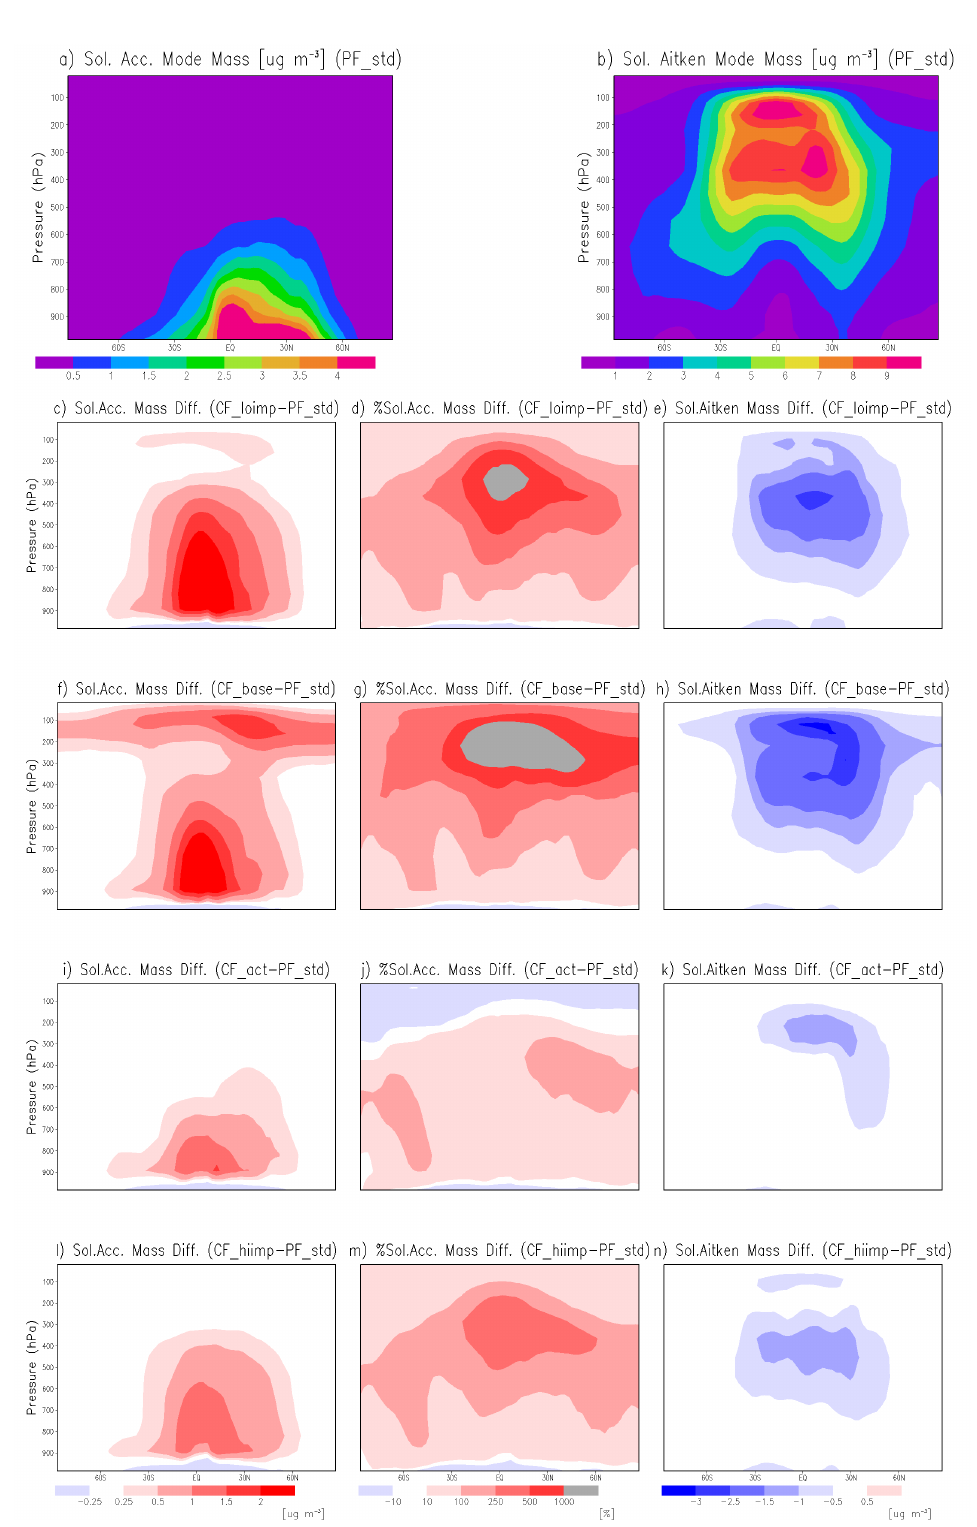
Fig. 3. The zonal and annual mean soluble/internally mixed (Sol.) accumulation (Acc.) and Aitken mode mass concentration at STP for the simulation PF std (top panels), and the difference of the four calculated scavenging fractions simulations with respect to simulation PF std (remaining left and right side panels). The percent difference in accumulation mode mass concentration of the calculated fraction simulations with respect to simulation PF std is shown in the center panels. All simulations are described in Table